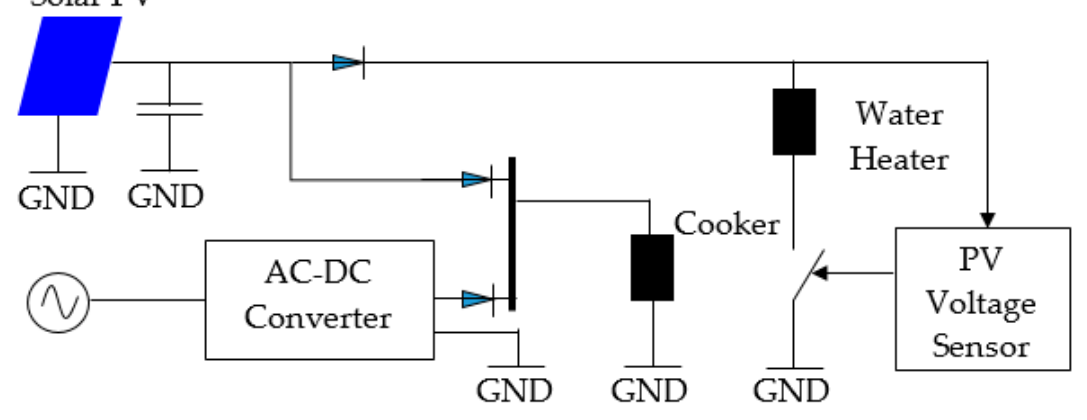
Figure 2. Schematic diagram of the cooking system.